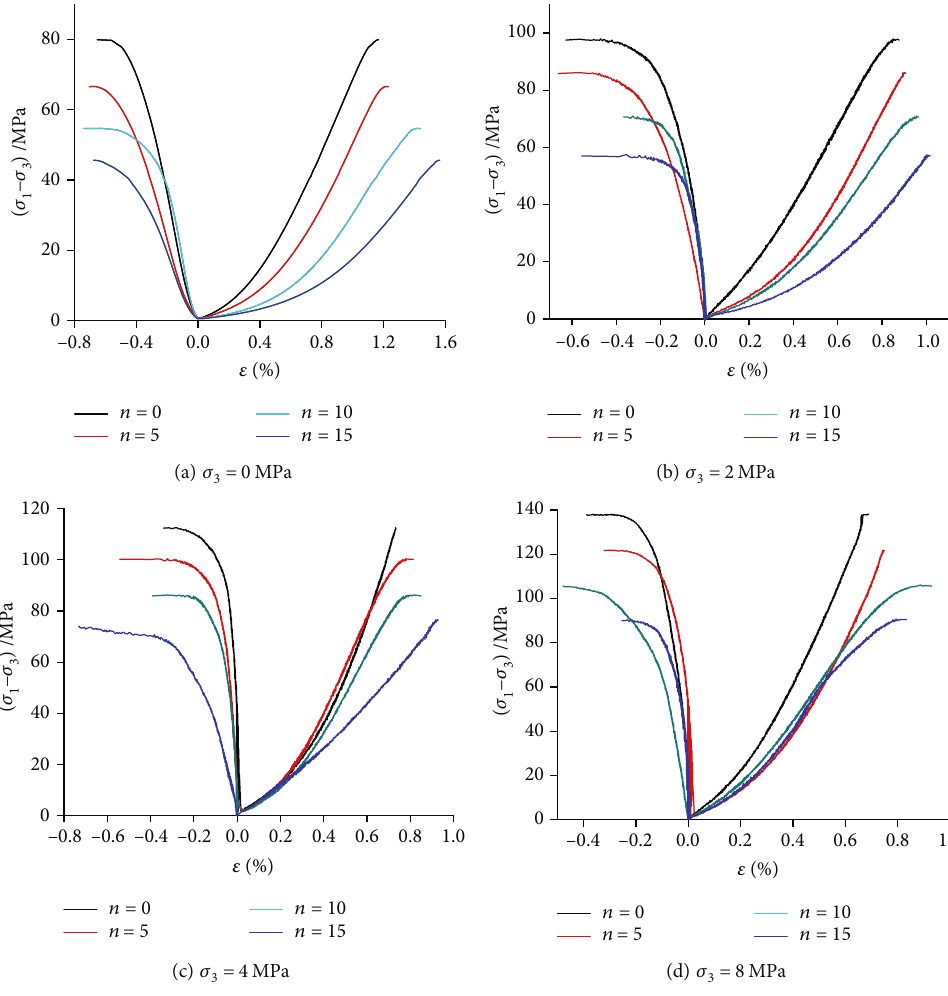
Figure 6: Stress – strain curves at di ff erent con fi ning